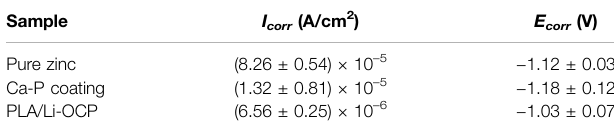
TABLE 2 | The corresponding corrosion parameters including corrosion potential and the corrosion current